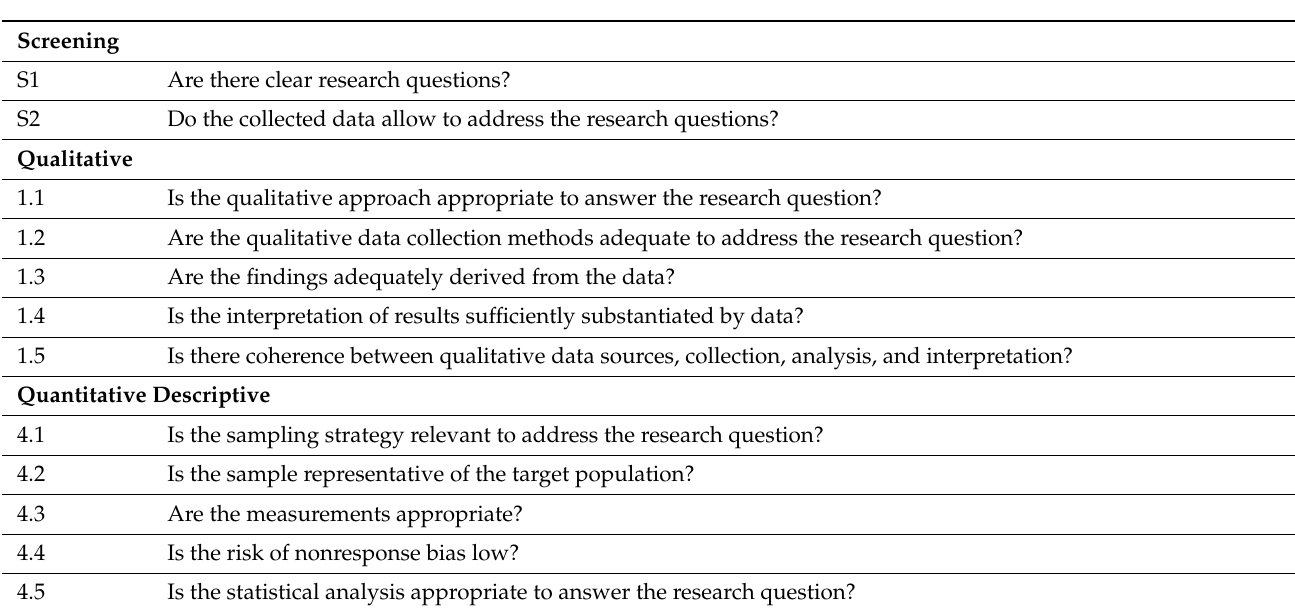
Table 3. MMAT criteria definitions